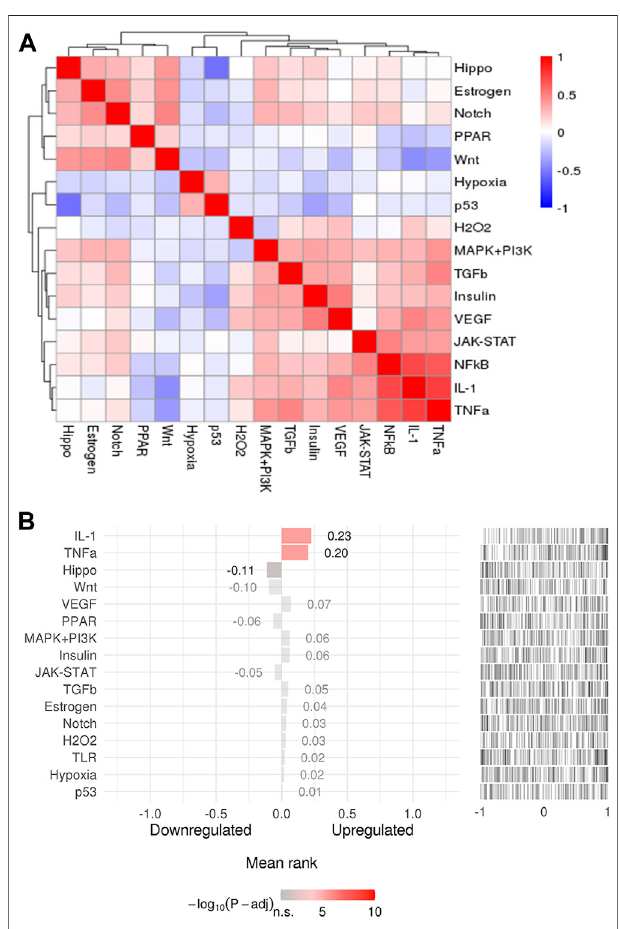
FIGURE6|(A) Thepathwayclustersfor192genes. (B) Pathwayactivity ranking (adjusted p -value < 0.05). The colors indicated adjusted p -value, and the brighter the color, the higher the